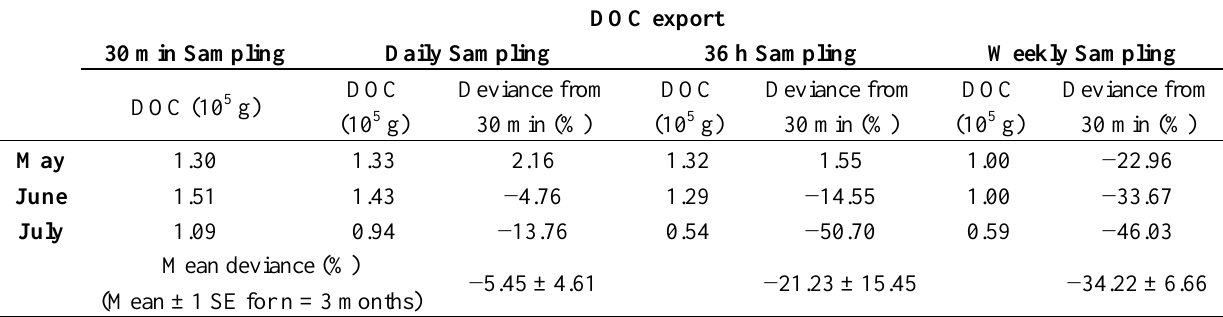
Table 2. Effect of measurement frequency on calculated DOC